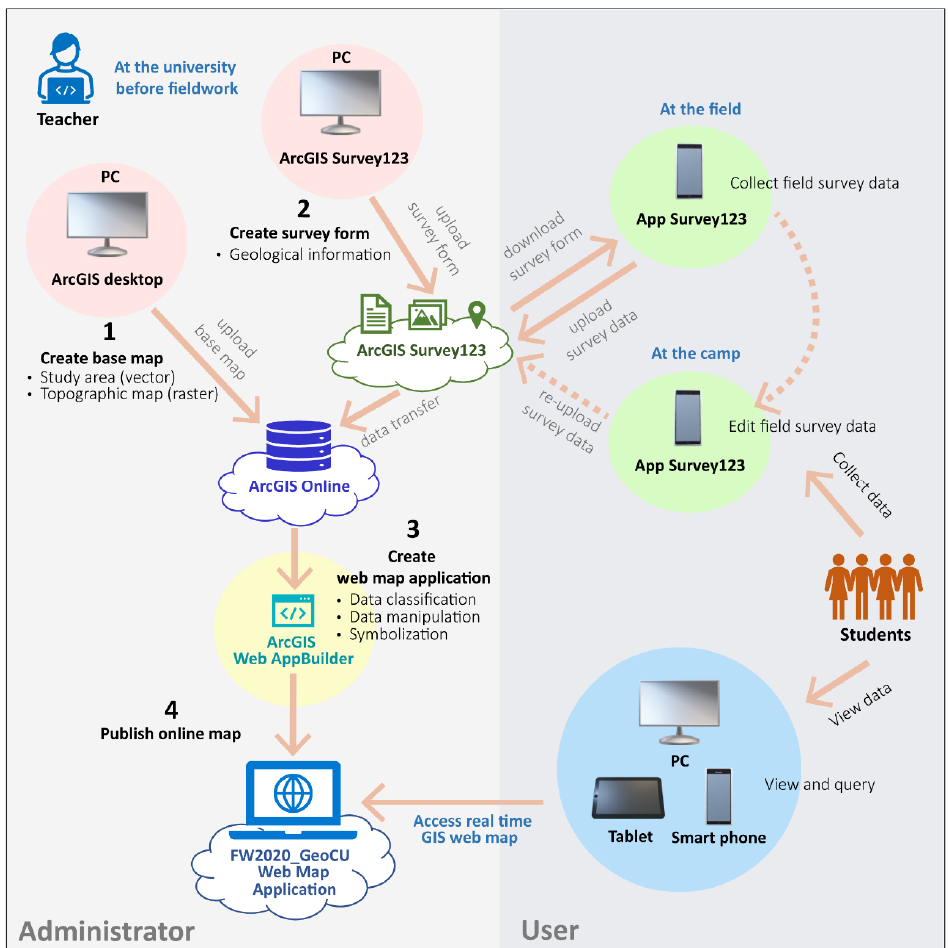
Figure 1. A typical workflow for constructing a fieldwork teaching with ArcGIS Online application.